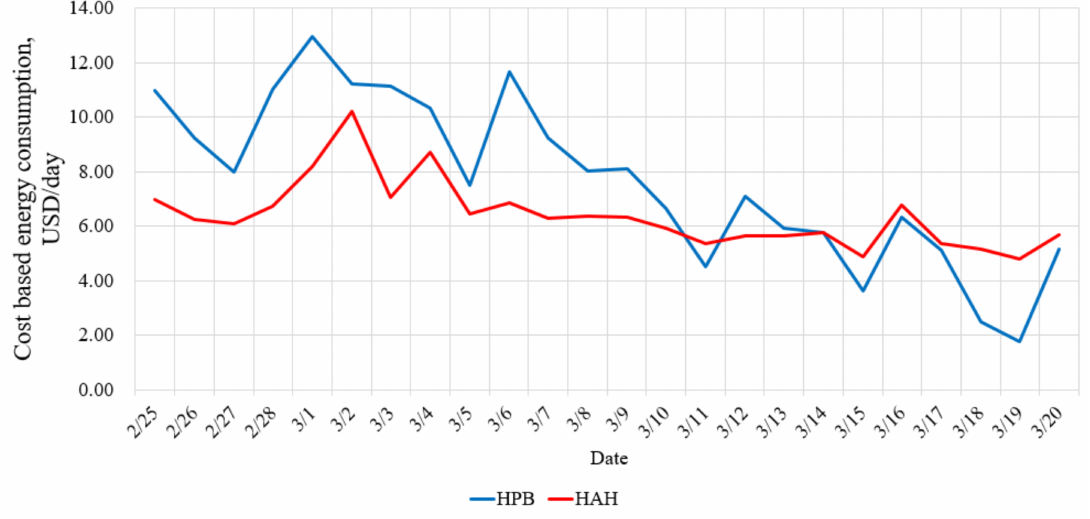
Figure 12. Comparison of heating cost according to energy consumption of HPB and HAH